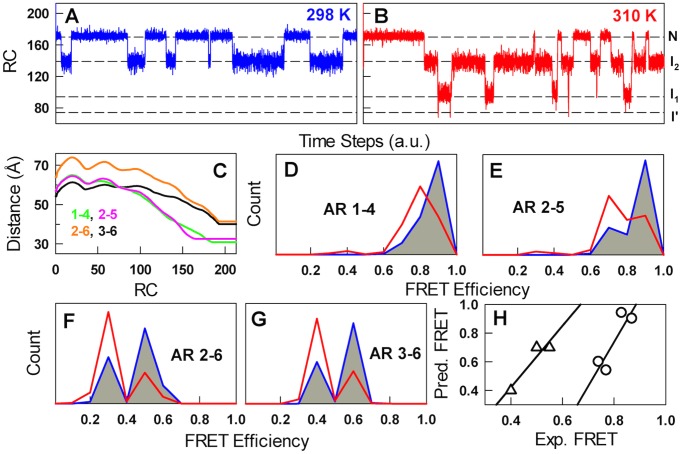
Native state dynamics.(A and B) Single-molecule Monte-Carlo dynamic traces along the reaction coordinate value at two temperatures. (C) Distances between various repeats (1–4, 2–5, 2–6 and 3–6) calculated from the 2D structural ensemble and projected onto the 1D profile as a function of the number of structured residues. (D–G) Binned FRET efficiency histogram indicating that the number of peaks, their positions, and amplitudes are dependent on temperature and on the construct studied. (H) Correlation between experimental and predicted FRET peak positions. Circles correspond to the major peak at 298 K while the triangles indicate FRET position of the minor peaks that appear at 310 K (the data for AR 2–6 is not available).